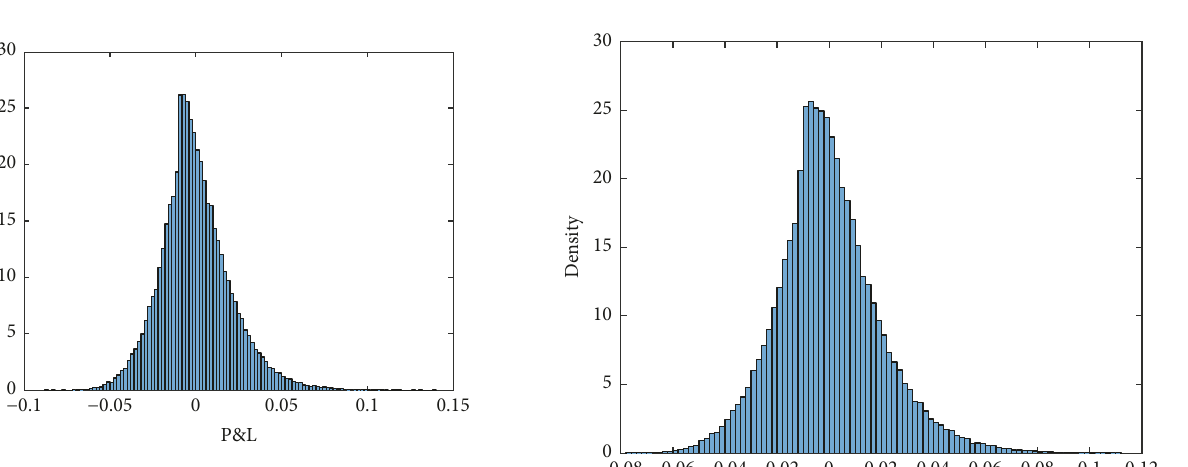
Figure 8: Distribution of P&L on MEGB2 returns.